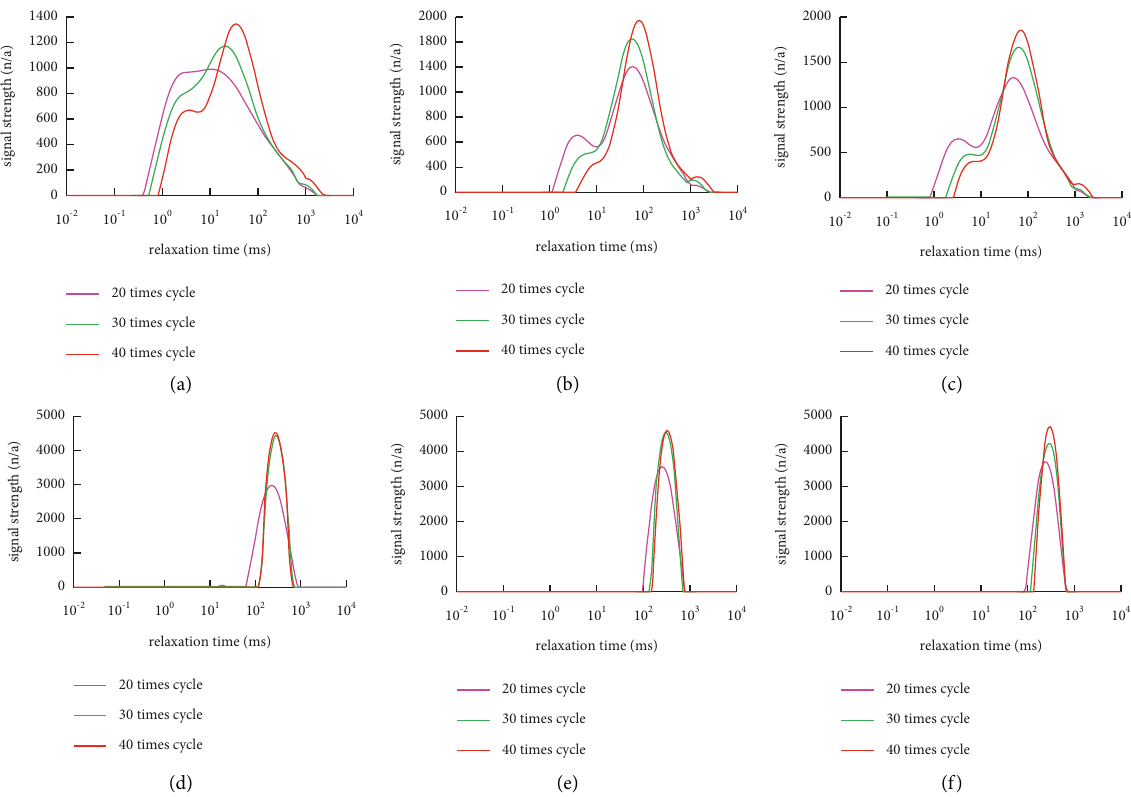
Figure 9: T 2 map of freeze-thaw cycles in group C and F . (a) C -1. (b) C -2. (c) C -3. (d) F -1. (e) F -2. (f) F -3.